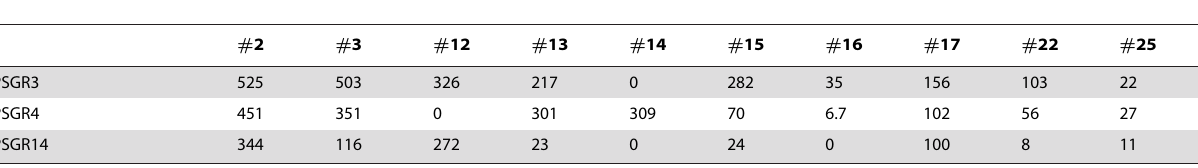
Table 3. Induction of peptide-specific T cells from the PBMCs of HLA-A2 + prostate cancer